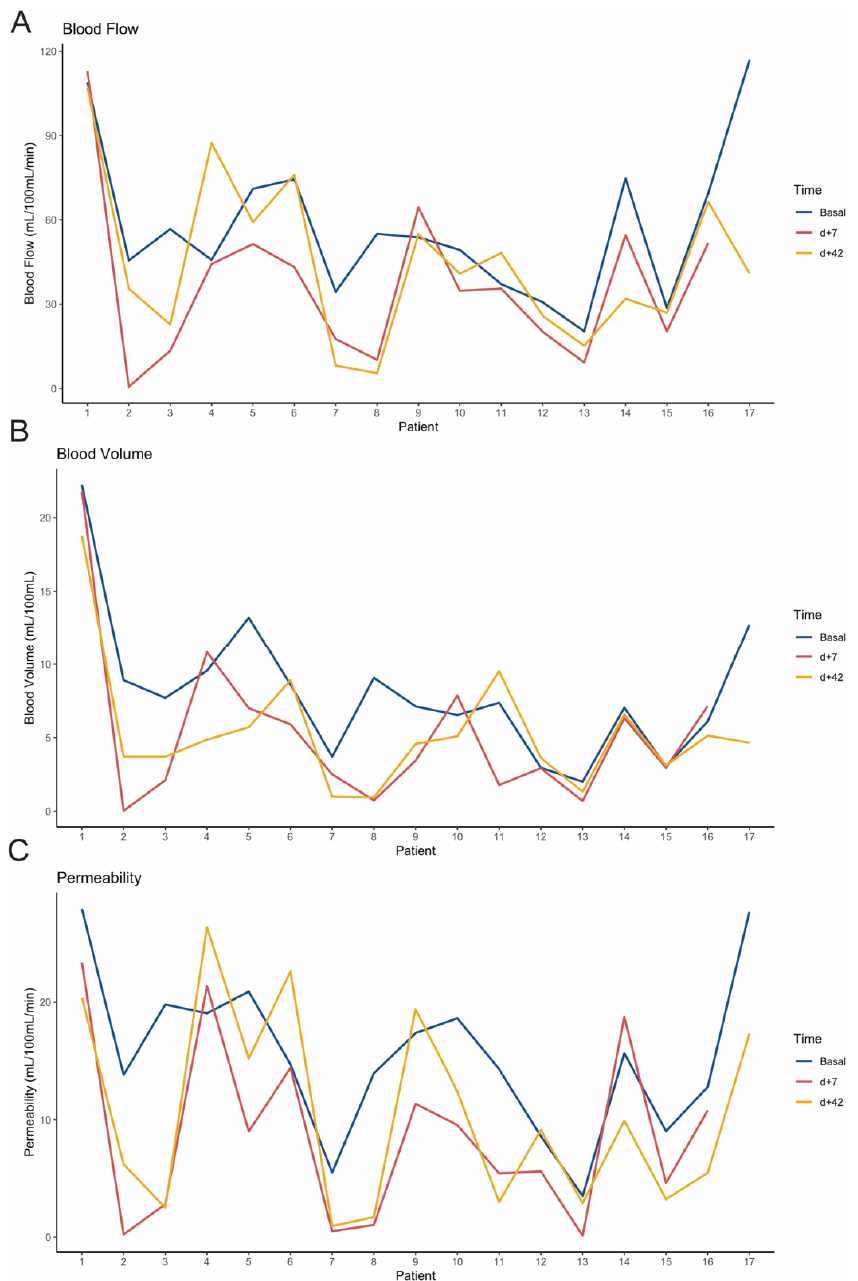
Figure 2. Line charts showing individual values of blood flow ( A ), blood volume ( B ), and permeability ( C ) at baseline (blue line), day +7 (red line), and day +42 (yellow line) after treatment initiation, case by case.